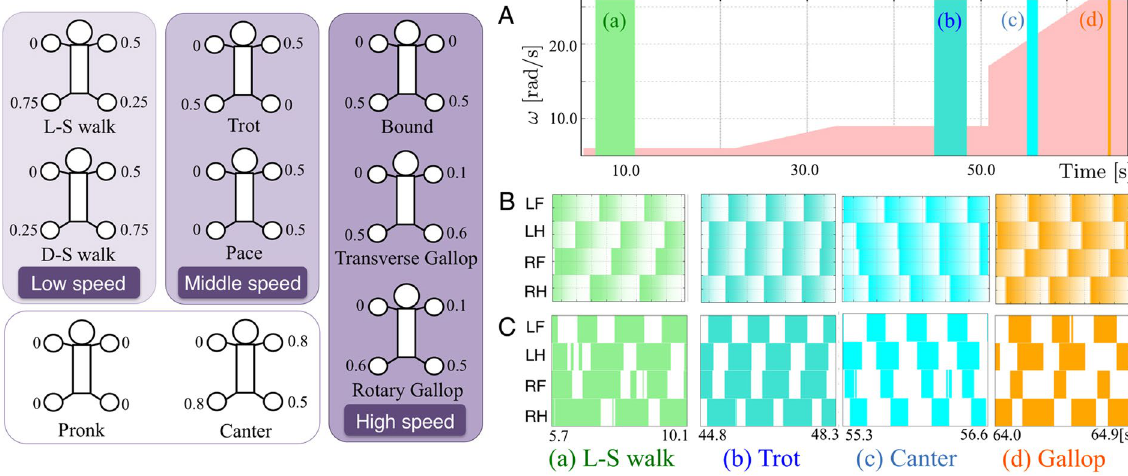
Figure 1. Gait patterns in quadruped animals 2 . The values shown around the feet represent the typical phases relative to the left fore (LF) leg. ( A ) Gait transition experiment. Profile of parameter ω . We used the parameter value σ = 6.0 [rad/Ns]. An abrupt change in ω at t = 50.6 s corresponds to the jump over the unstable gap between the trot and gallop gaits (see the instability in Fig. 3(C) at ω = 12.0, 14.0. We explain the reason for this in detail in the SM). ( B ) Evolution of the oscillator phase in each leg. The coloured shading represents the phase value (color: φ i = 0, white: φ i = 2 π ). ( C ) Gait diagrams. The coloured regions represent the stance phase, during which the sensor value N i becomes greater than a threshold value (10% of maximum